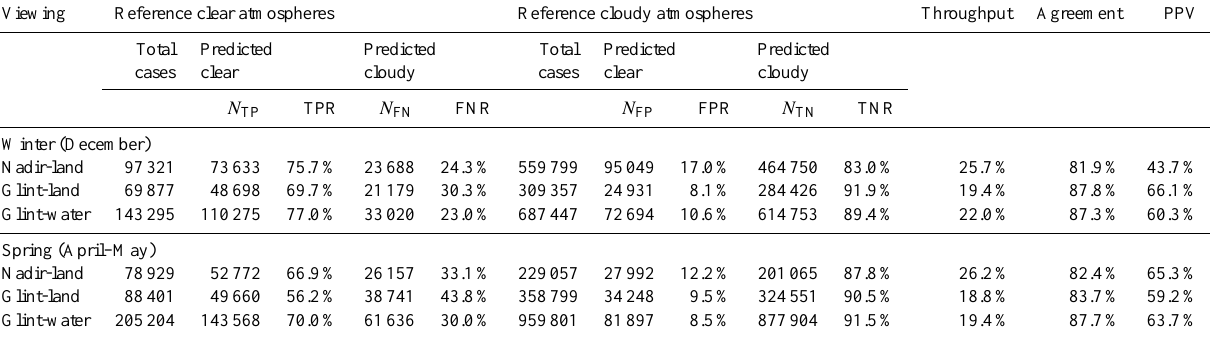
Table 3. Contingency tables for the comparison of the OCO-2 cloud screening preprocessors to MODIS cloud mask. Results are shown for the three main viewing scenarios for both the winter (December) and spring (April–May) data sets. Viewing Reference clear atmospheres Reference cloudy atmospheres Throughput Agreement PPV Total Predicted Predicted Total Predicted Predicted cases clear cloudy cases clear